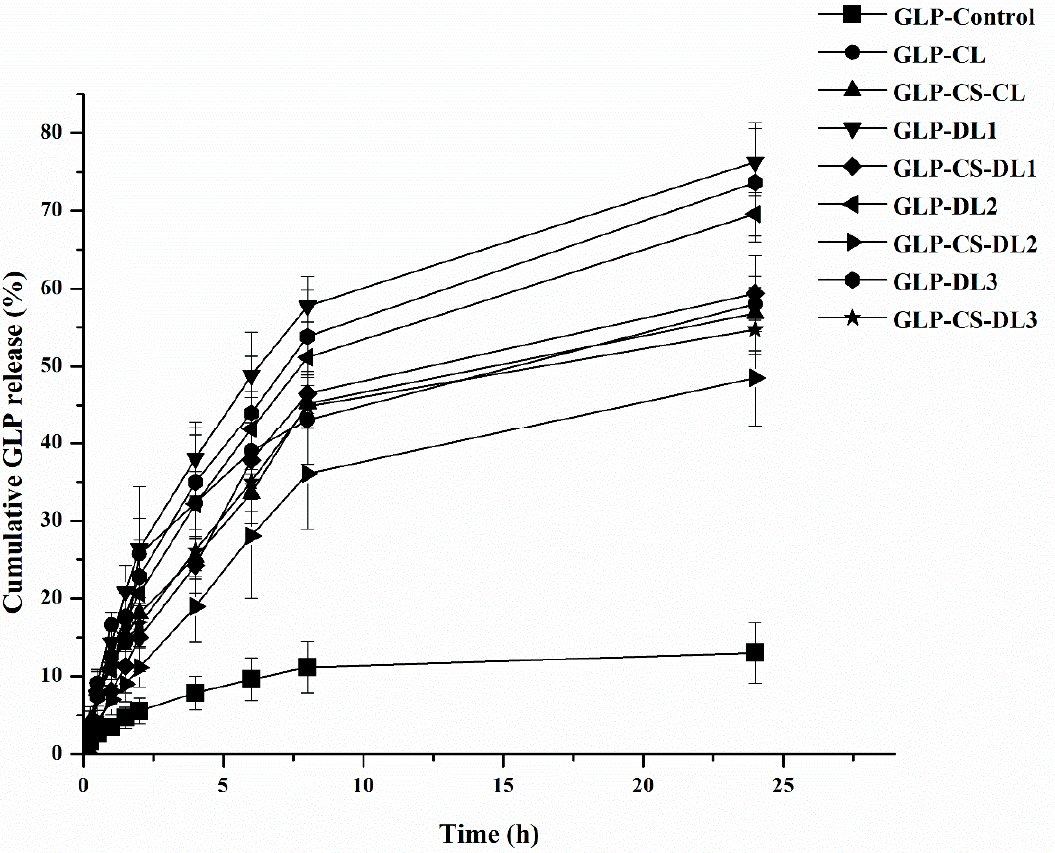
Figure 2. In vitro release profiles of GLP-loaded CL-, DL-, and CS-coated CL/DL in PBS solution (pH 7.4) containing 0.5% Tween 80 (mean ± SD, n = 3).